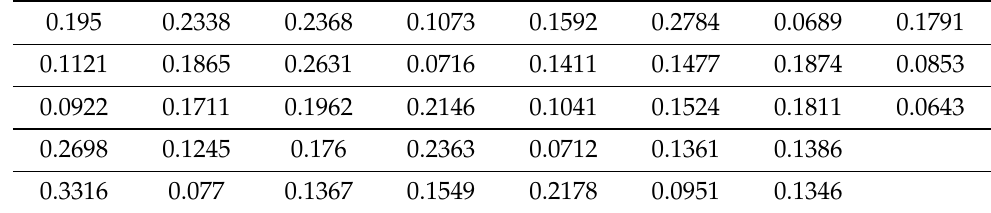
Table 13. Recovery rate of COVID-19 Data in